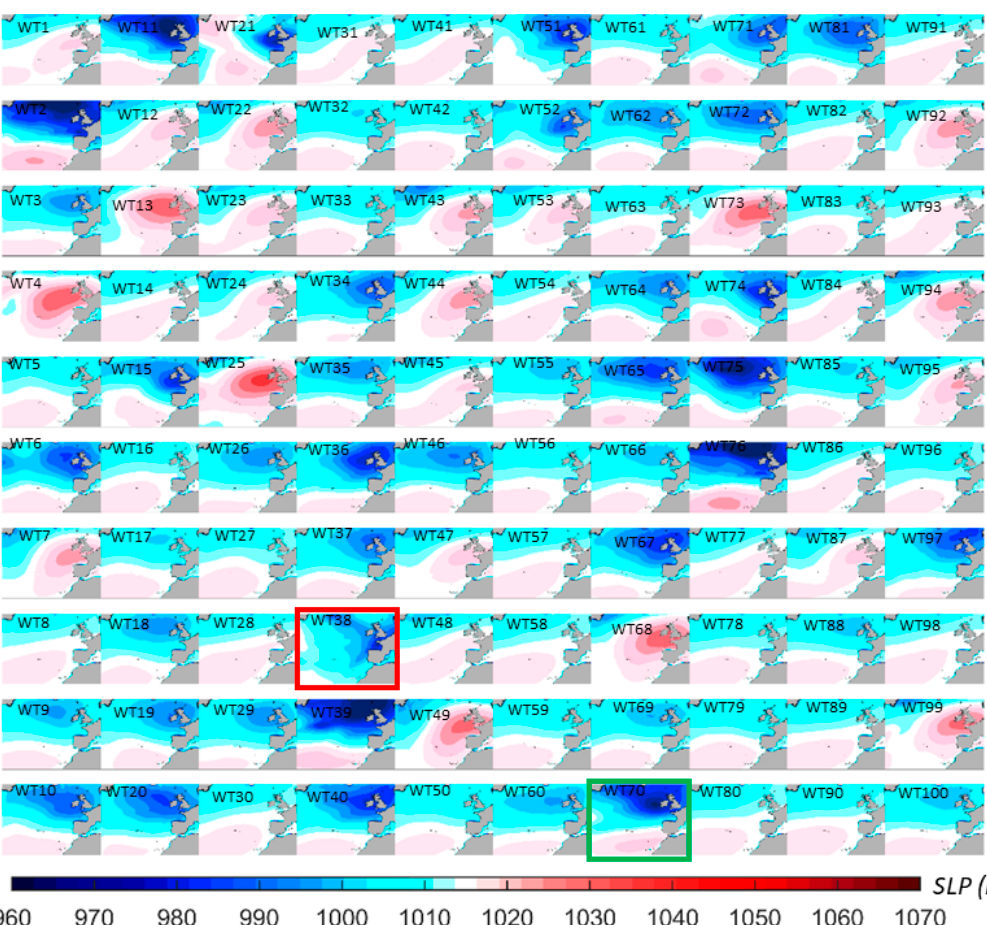
Figure 7. Daily minimum SLP associated with each of the 100 weather types of the SD1 model, using a fully supervised regression classification. Calibration period: years from 2000 to 2014, excluding 2012, which is the validation period. WT38 and WT70 show the atmospheric pattern of the Xynthia (red rectangle) and Joachim (green rectangle) storms, respectively.